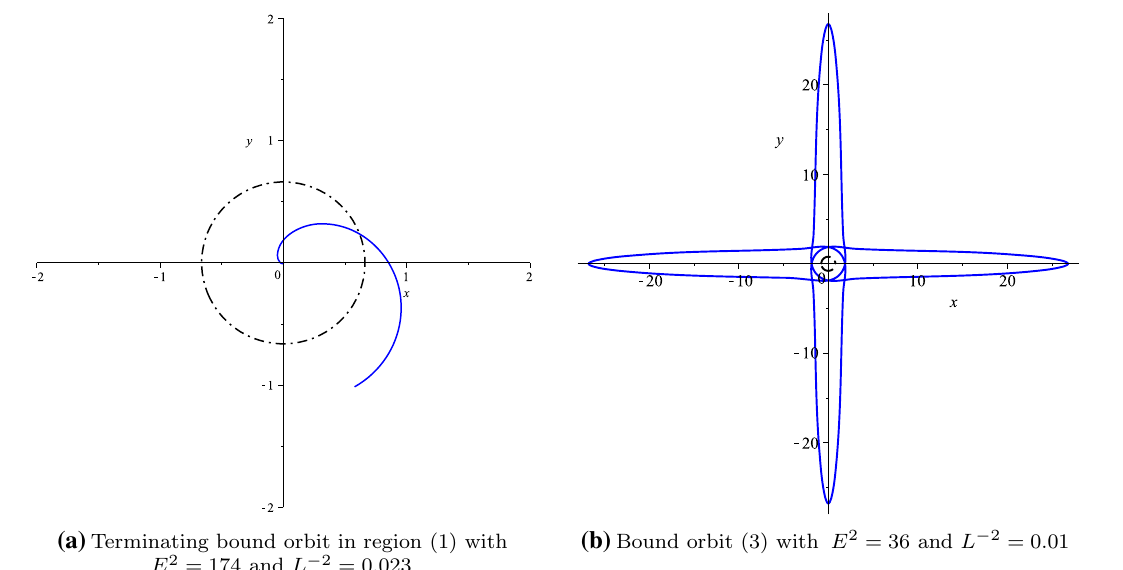
( a ) Terminating bound orbit in region (1) with E 2 = 174 and L − 2 = 0 . 023 Fig. 11 Timelike geodesics in the uncharged BTZ black hole in massive gravity with (cid:4) = − 0 . 01, m (cid:5) = 2 . 54 and m 0 = 2. The dashed dot line represents horizons Fig. 12 The regions of different geodesic motion for massless particle in the charged BTZ black hole in massive gravity with m 0 = 1, m (cid:5) = 1 and r 0 = 1. On the left q 2 = 1, on the right (cid:4) = − 0 . 1. The red dashed line corresponds to b − 2 + (cid:4) = 0, where the asymptotic for r → ∞ switches sign. The numbers in parentheses indicate the number of real positive roots